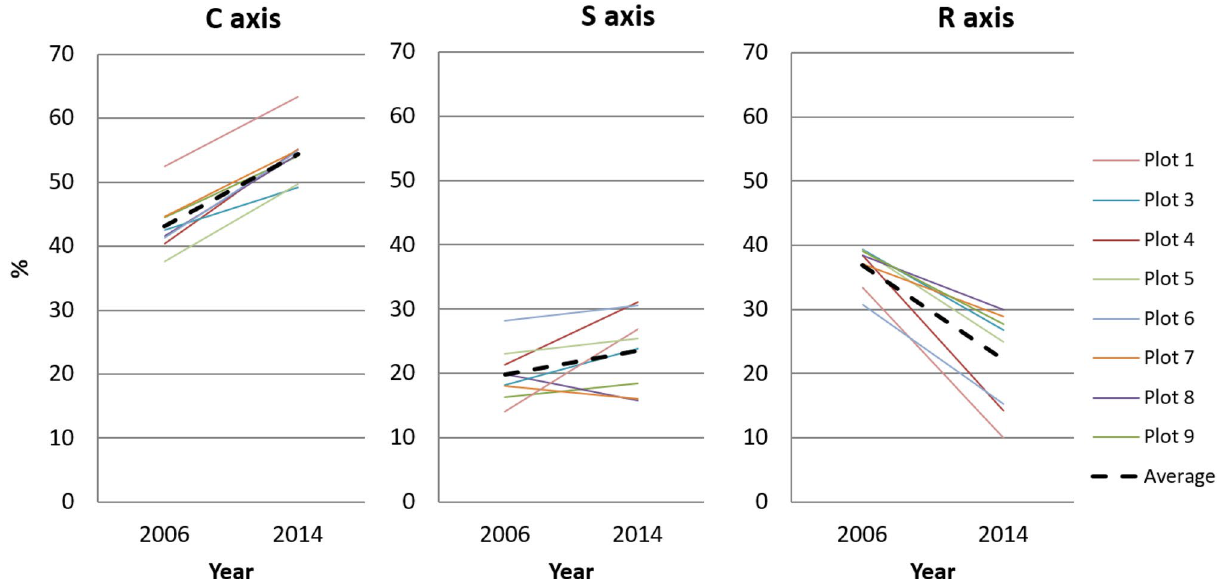
Figure 5. Changes in the community-weighted mean (CWM) C, S, and R scores at experimental plots. Dashed lines indicate averaged values.